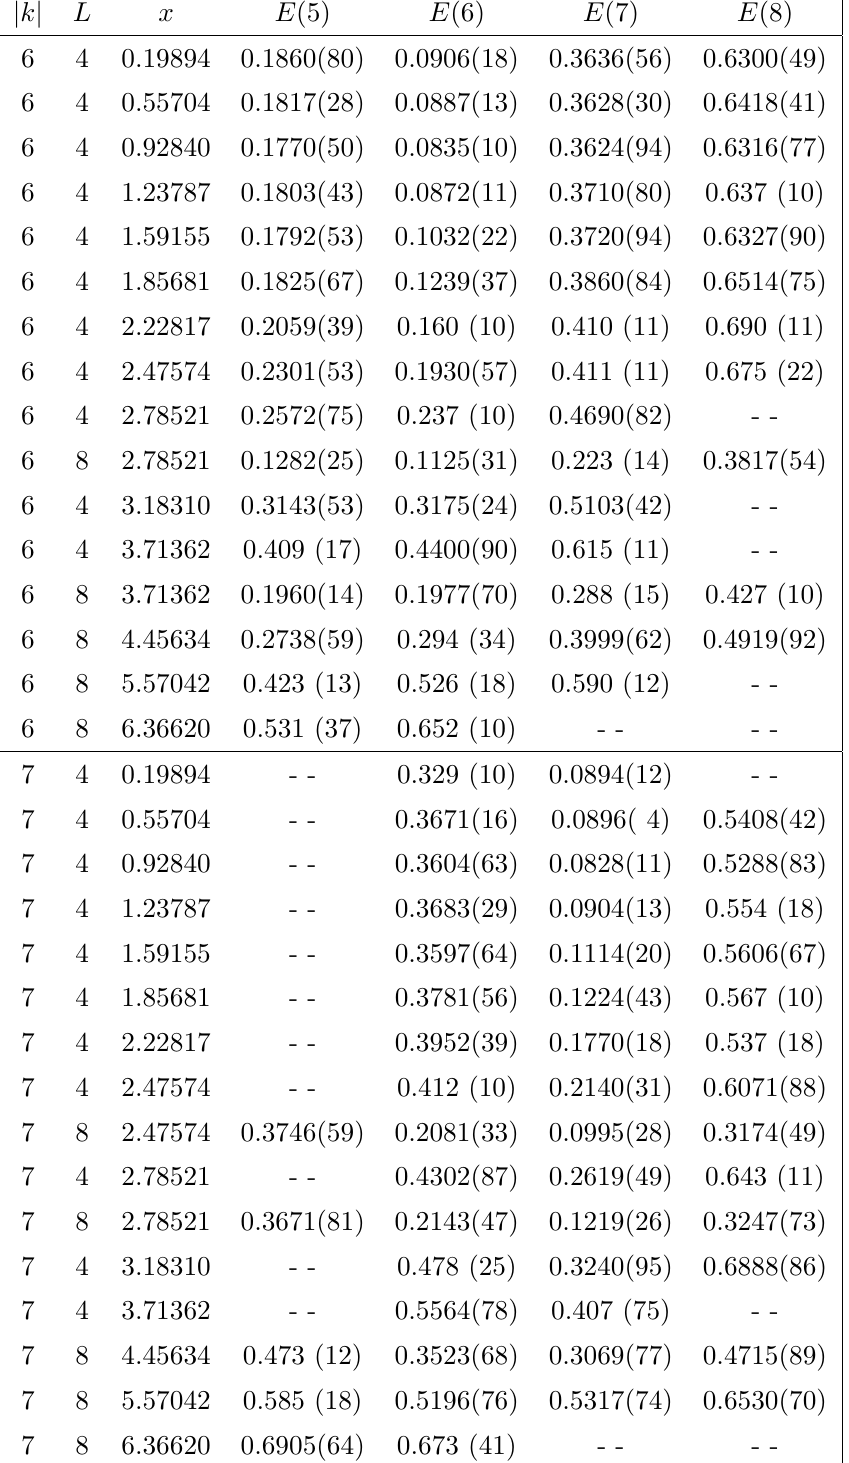
Table 15. SU(17) torelon energies (in lattice units)